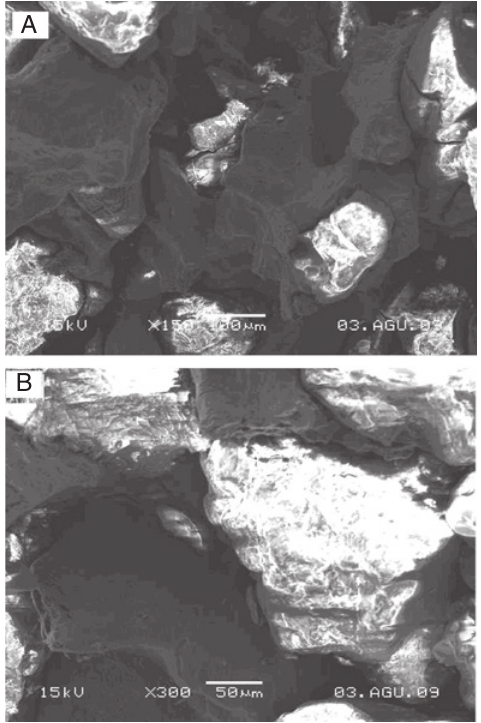
Figure 7: Fracture surface of composite with a 210- μ m reinforce- ment particle size; (A) composite and (B) matrix-reinforced surface.